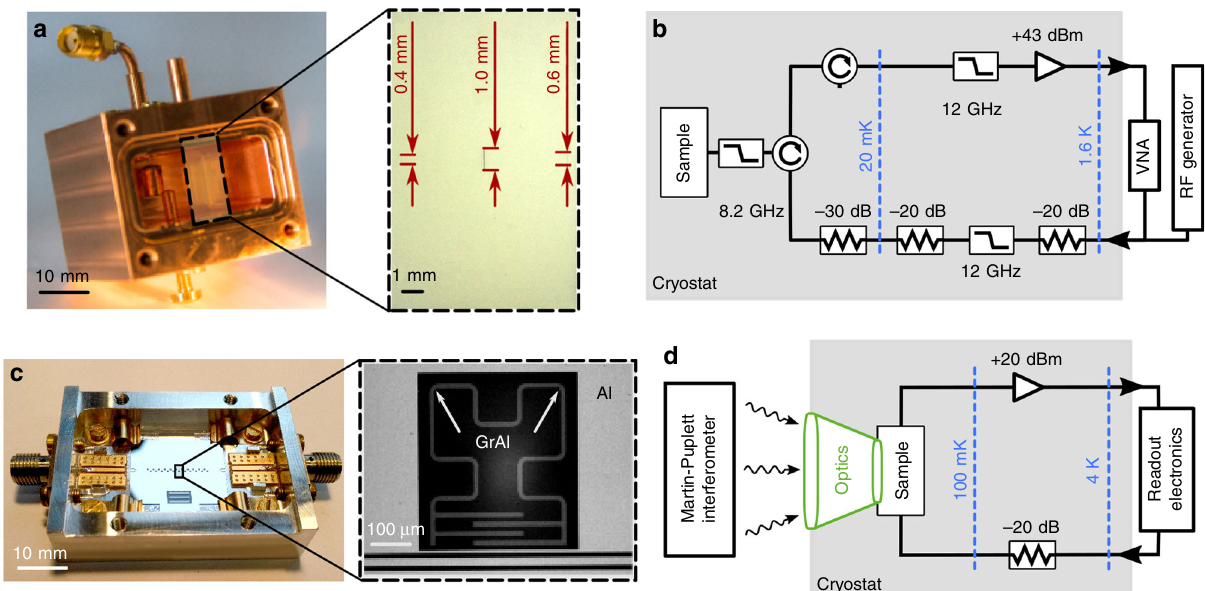
Fig. 2 Two complementary microwave measurement techniques for the study of grAl resonators (grAl#1). Low-frequency setup: a Photograph of the Cu waveguide sample holder used to perform re fl ection measurements on stripline grAl resonators. The inset photograph shows three of the measured resonators, with dimensions 400 × 5.4 μ m 2 , 600 × 10 μ m 2 , and 1000 × 40 μ m 2 . All resonators are 20-nm thick (see Supplementary Discussion).